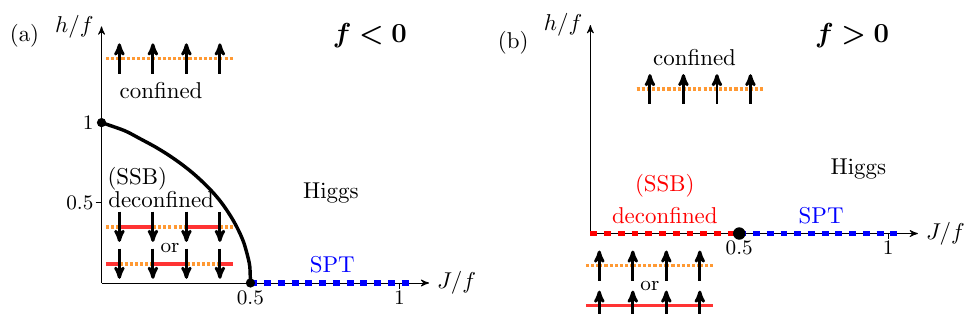
Figure 7: Phase diagram of the gauged TFIM (62) for f < 0 and f > 0, respec- tively. In absence of vortices ( h = 0), the system enjoys the magnetic symmetry (cid:81) σ z W = , protecting the SPT order in the Higgs phase (highlighted by dashed j j + 1 / 2 blue line). For h (cid:54) = 0, the Higgs and confined regimes are adiabatically connected. For f < 0 the solid black line denotes Ising criticality, which is stabilized due the translation-breaking nature of the antiferromagnetic phase, similar to the discussion in section